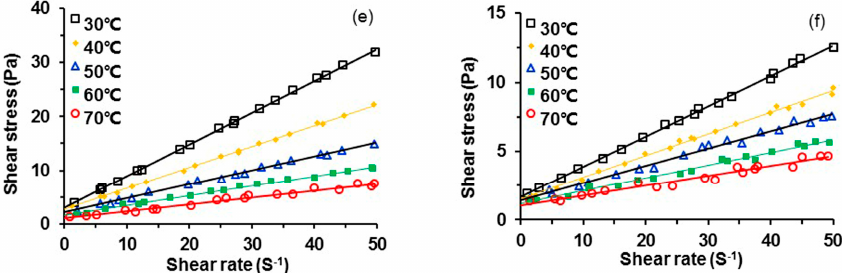
Figure 5. Rheological curves for: ( a ) oil sample #1; ( b ) oil sample #2; ( c ) oil sample #3; ( d ) oil sample #4; ( e ) oil sample #5; and ( f ) oil sample #6.